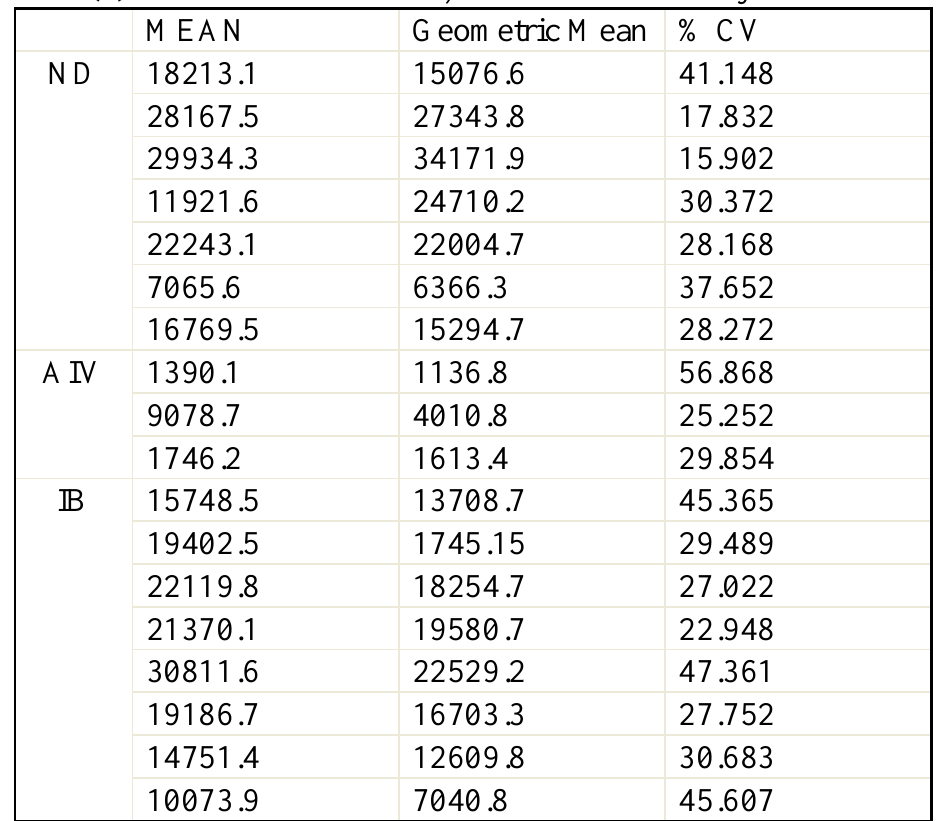
Table (3): ELISA results of ND, AIV and IB antibody titres of 2006